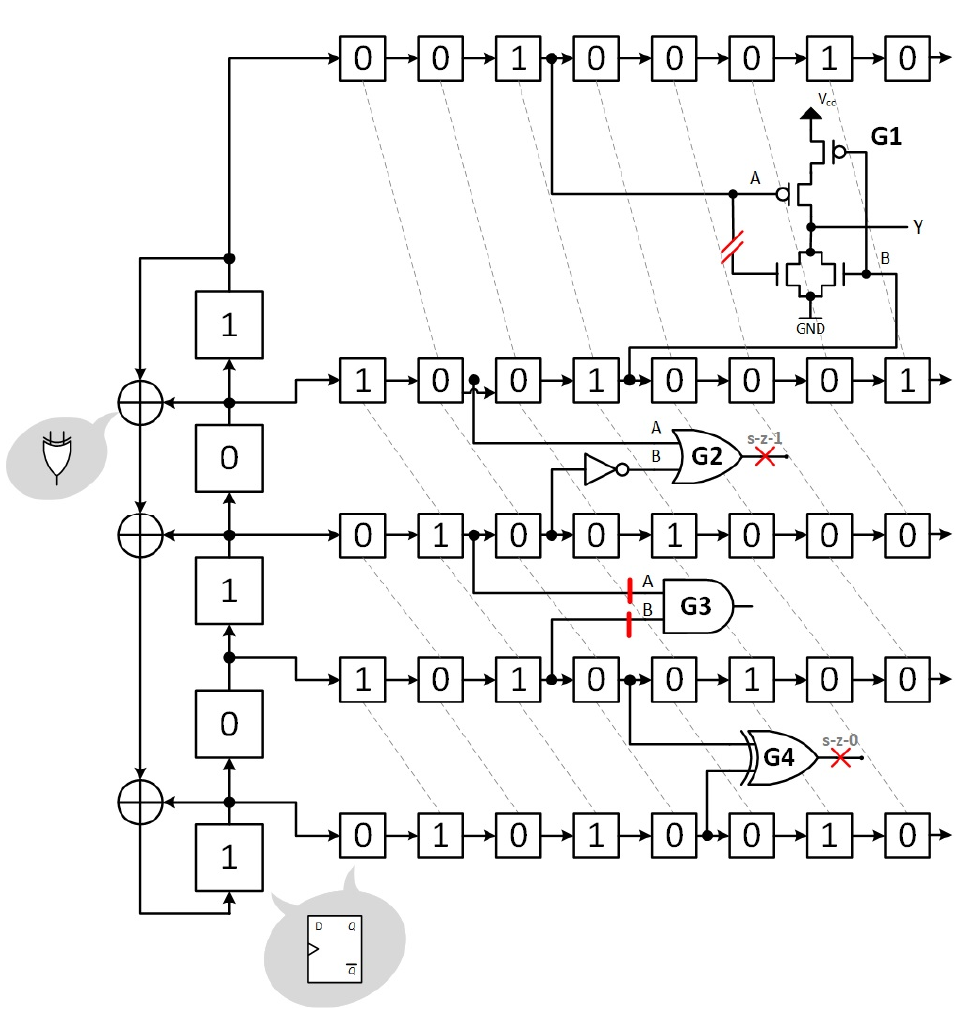
Figure 2. The example of faults that are undetectable by means of a conventional STUMPS-type LBIST structure. LBIST